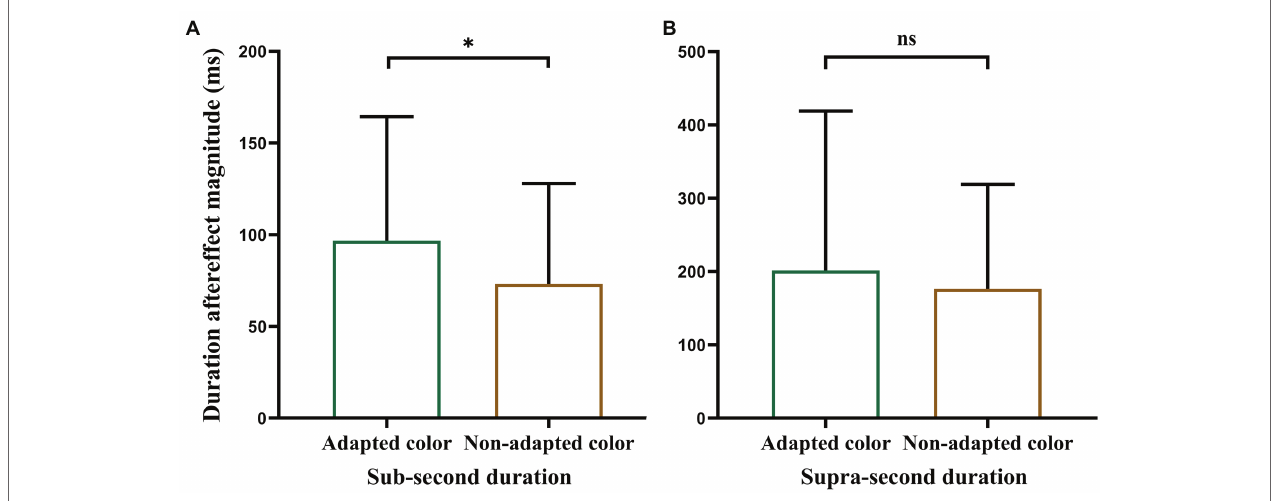
FIGURE 3 | Plot of paired-samples t -test. (A) Refers to Experiment 1 and (B) to Experiment 2. Error bars represent standard errors. * p <